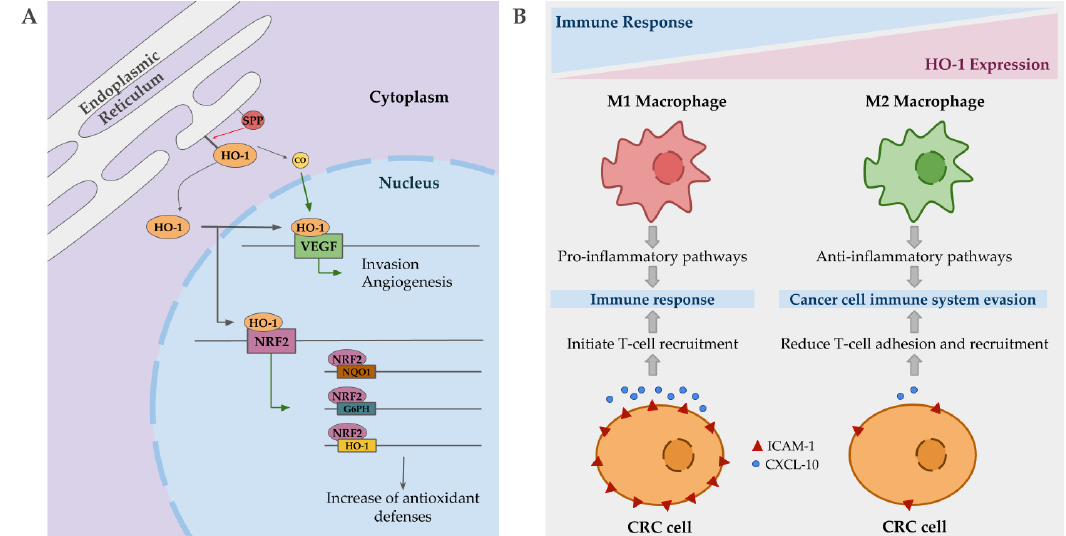
Figure 3. Mechanisms by which heme oxygenase 1 (HO-1) may contribute to cancer progression. ( A ) Signal peptidases (SPPs) mediate HO-1 compartmentation to the nucleus, where it regulates the expression of vascular endothelial growth factor (VEGF), promoting angiogenesis and invasion. CO, in a tumorigenic environment, may also promote the same previous effect. HO-1 also regulates nuclear erythroid 2-related factor (Nrf2) expression, which in turn regulates the expression of antioxidant enzymes such as HO-1, G6PH, and NQO1, enhancing the antioxidant capacities of the tumor cells. ( B ) HO-1 expressing macrophages are polarized into M2 state, promoting anti-inflammatory pathways and facilitating cancer cell to evade the immune system. In colorectal cancer (CRC) cells, the overexpression of HO-1 results in low levels of ICAM-1 and CXCL-10, reducing T-cell adhesion and